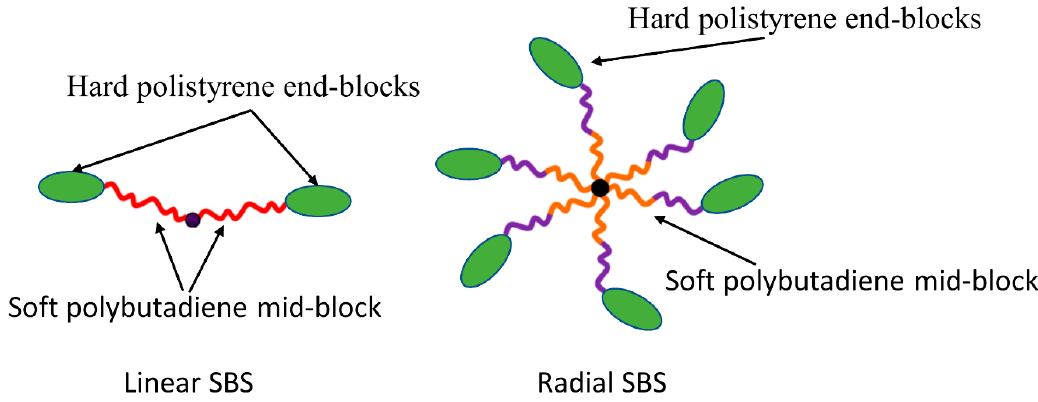
Figure 4. Representation of linear and radial SBS (reconstructed from [61] open access).